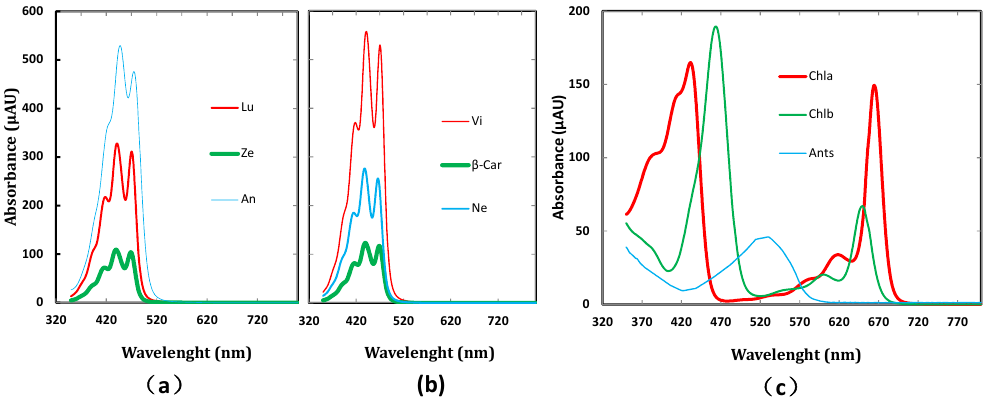
Figure 2. The absorption spectra of pure pigments in acetonitrile/methanol/dichloromethane (60:20:20 v / v / v , pH = 5) with a few 37% HCl solution. The content of Lu, An, Ze in ( a ) and Ne, Vi, β -Car in ( b ) were both 0.2 mg/mL and Chl a , Chl b in ( c ) were 0.01 mg/mL and Ants in ( c ) were 0.05 mg/mL.